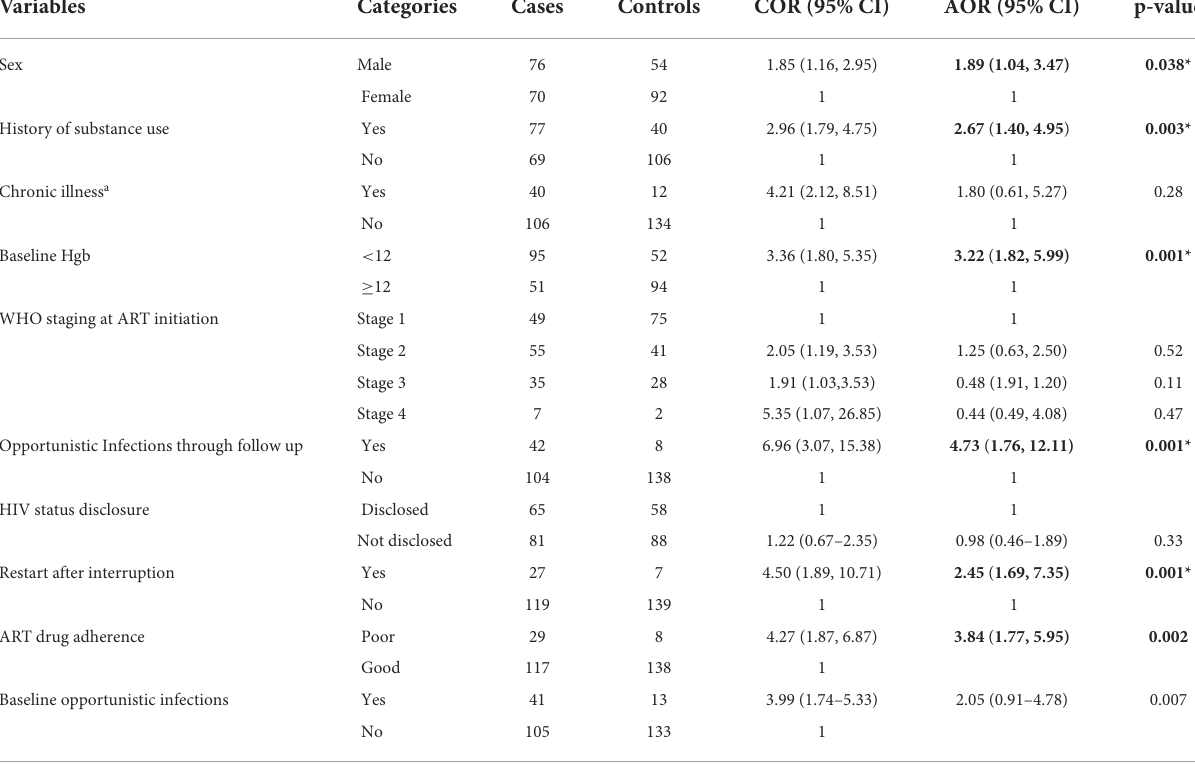
TABLE 4 The bivariable and multivariable logistic regression analyses for factors associated with virological failure among first-line HAART at MTUTH in